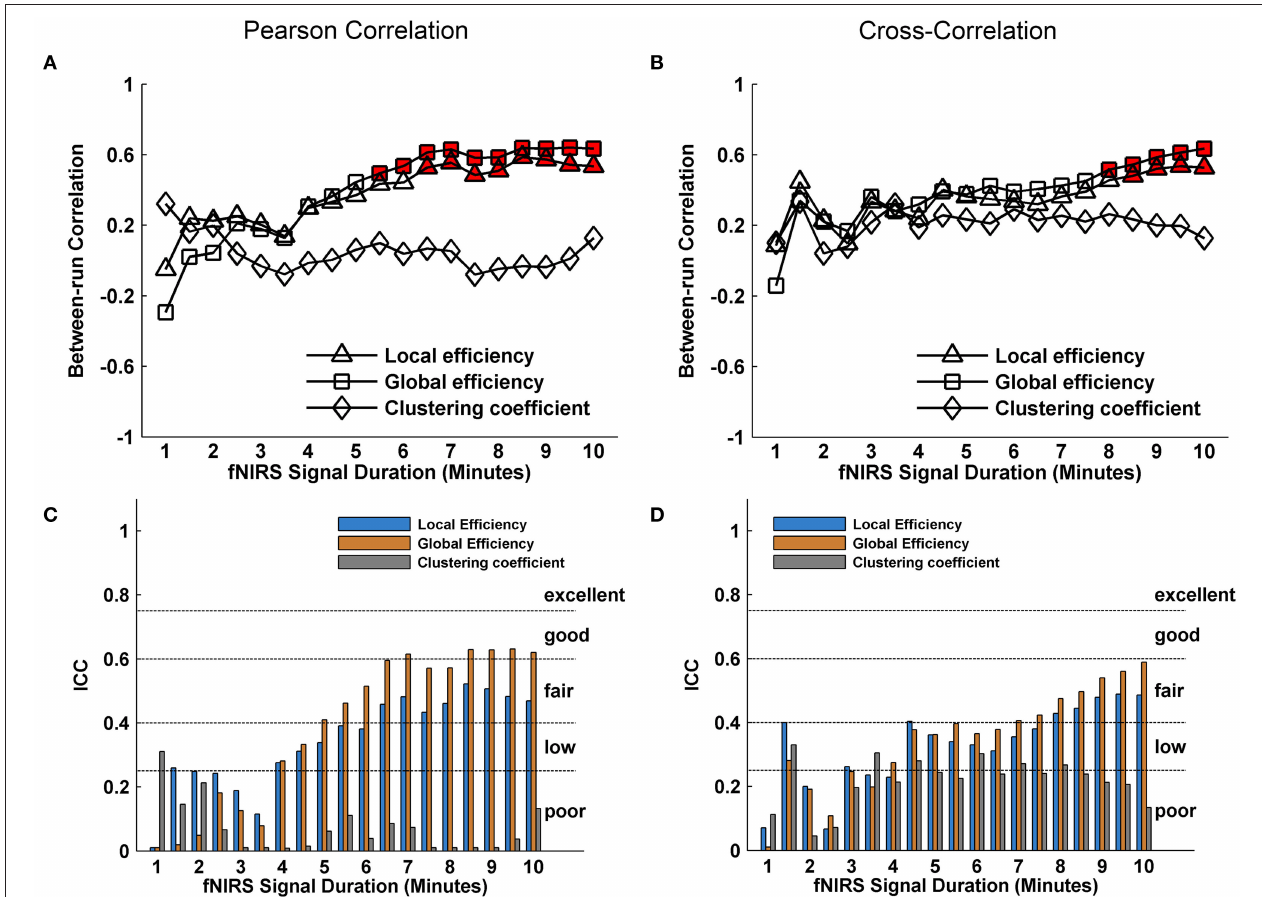
FIGURE 7 | Evaluation of the effect of fNIRS signal acquisition duration on the reproducibility of local efficiency, global efficiency and clustering coefficient. The local efficiency, global efficiency, and clustering coefficient in (A) and (C) were calculated from Pearson correlation-derived networks. (A) Between-run correlation coefficients for the global network metrics plotted by duration of fNIRS signal acquisition (1.0–10.0 min in 30-s bins). The red-filled shapes indicate significant correlations between two runs at the same signal acquisition bin for the global network measures. (C) The ICC values for the global network metrics, respectively. (B) was similar to (A) and (D) was similar to (C) except that the local efficiency, global efficiency, and clustering coefficient were calculated from cross-correlation-derived networks.